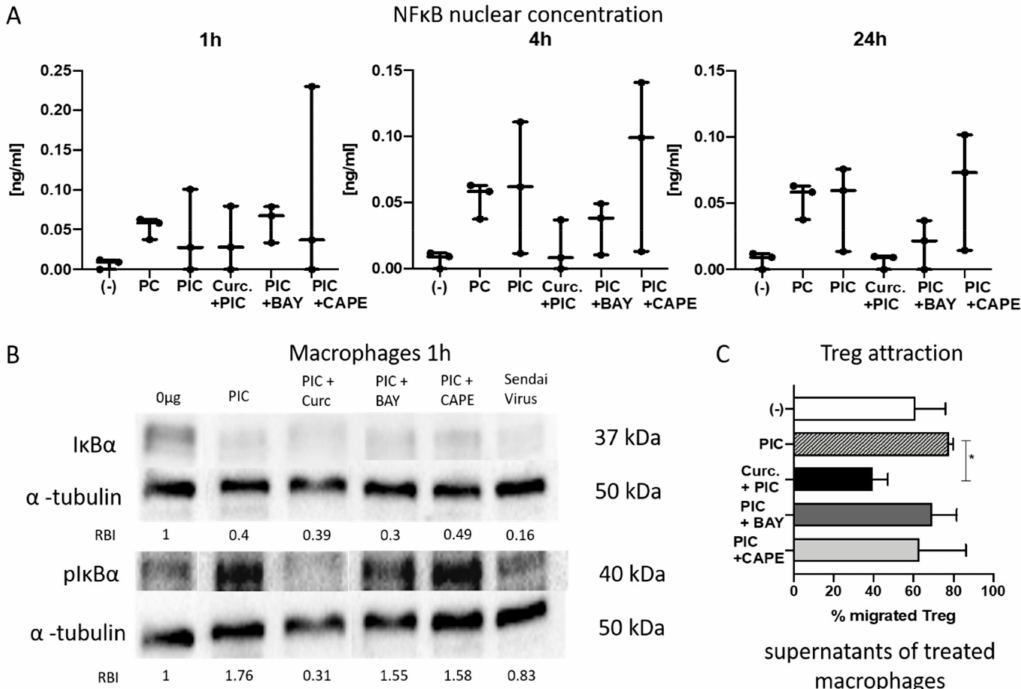
Figure 6. ( A ) Nuclear concentration of NF- κ B in macrophages after incubation with adjuvants for 1, 4, and 24 h. Concentra- tions were determined by ELISA. Note that treatment with curcumin (Curc.) and PIC shows after 4 h less activation than the treatments with PIC and BAY or PIC and CAPE. (-) indicates the negative control. n = 3. Bars represent minimum to maximum with a line at the mean. ( B ) Western blot for I κ B α , pI κ B α , and α -tubulin after 1 h of macrophage treatment as indirect evidence for activated or inactivated NF κ B. Relative band intensities (RBIs) were calculated between IkB α and α -tubulin or pIkB α and α -tubulin. The blot is representative for n = 3. Original blots can be found in Figure S1. ( C ) Treg attraction. Cancer specimens and macrophages were incubated with adjuvants for 24 h. After incubation, supernatants were harvested, and a migration assay was performed for 1.5 h. Flow cytometry was used to count migrated cells. n = 3 (PIC + BAY, PIC + CAPE), n = 4 ((-), PIC, Curc. + PIC). Bars represent mean with SEM. P- values were determined with the Mann–Whitney test, with * p < 0.05. The α -tubulin loading controls for I κ B α and pI κ B α shown in ( B ) are identical to the α -tubulin loading controls shown in Figure 5C since they are part of the same original blots; the figures are organized as shown to better align with the data persented in the results